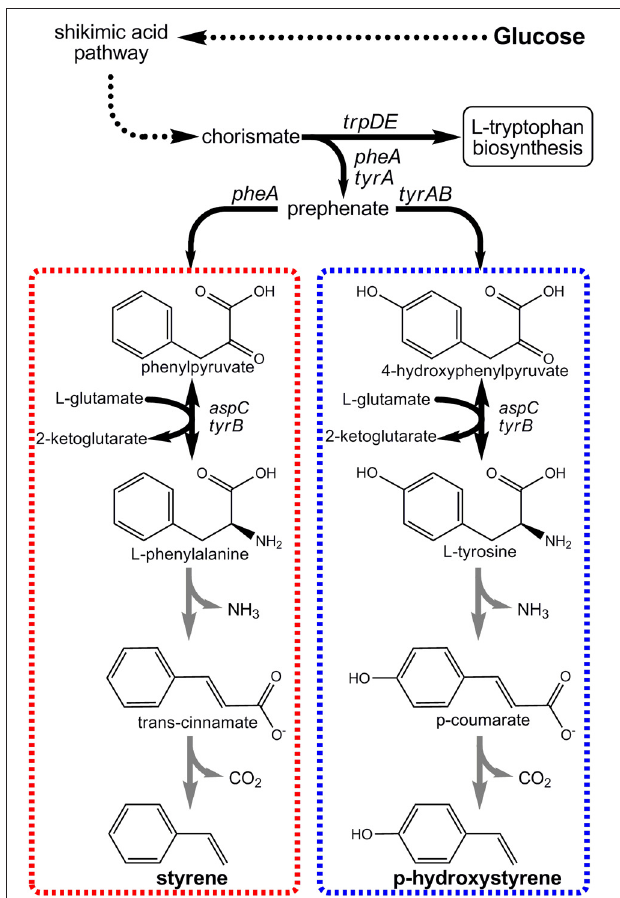
FIGURE 5 | Novel pathways engineered for the production of p-hydroxystyrene and styrene from renewable glucose via aromatic amino acid